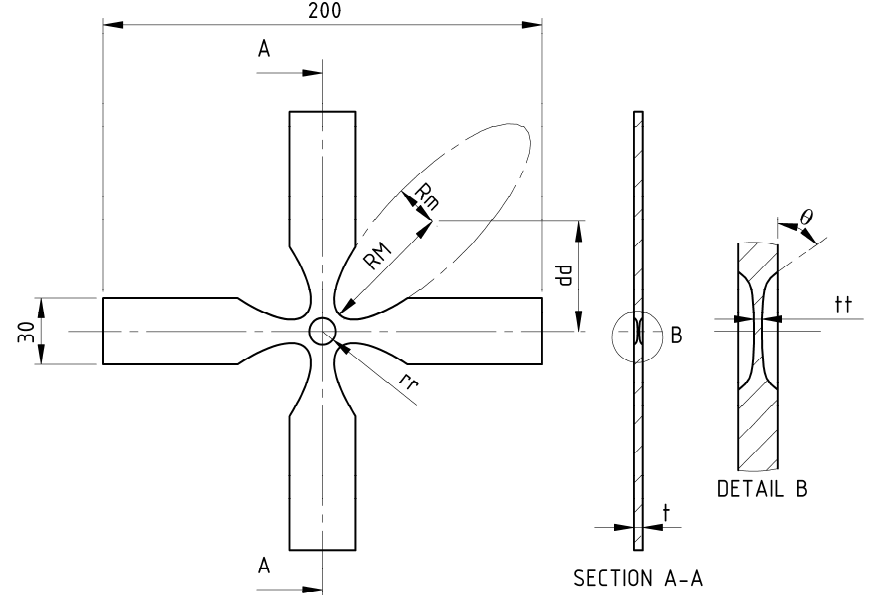
Figure 1: Specimen geometry, dimensions in mm.